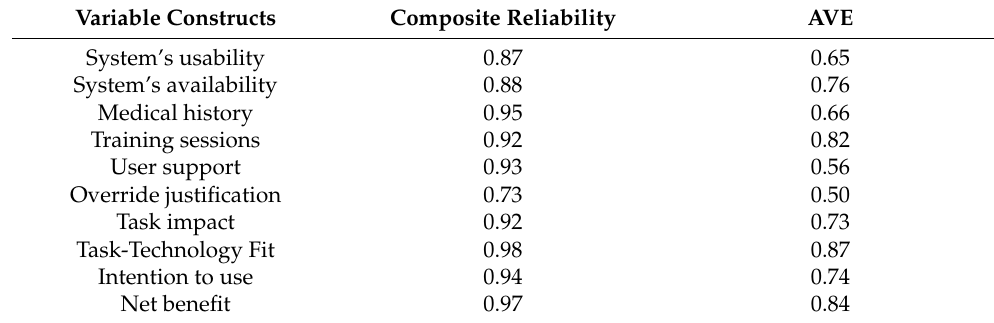
Table 3. Convergent